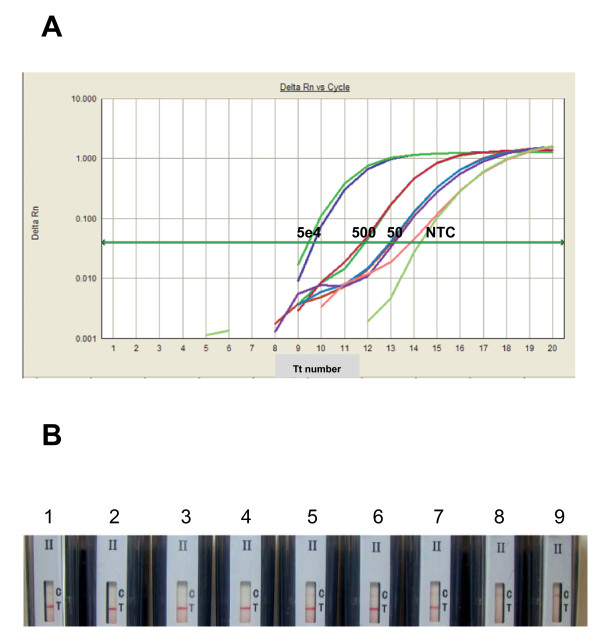
Rapid amplification and detection of Neisseria gonorrhea genomic DNA. Panel A) Fluorescence monitoring in real-time is shown as semi-log plot of fluorescence intensity versus Tt number where each cycle is 1 minute-long. The copy numbers of input template are labeled on the figure. Panel B) Type II BESt™ cassette detection of 5e4 copies/assay (strips 1-2), 500 copies/assay (strips 3-4), 50 copies/assay (strips 5-7), and non template control (NTC) (strips 8-9). The signal from NTC (either in panel A or B) is the amplification signal from the internal control sequence. The IC sequence shares the same primer sequence with the detected target gene of Neisseria gonorrhoeae, just with different internal nucleic acid sequence between the primers. The IC sequence is cloned into a plasmid. When a reaction is set-up, the IC plasmid is premixed with all of the other reaction components (except the target DNA or tested clinical samples) to prepare the master mix of the assay. When there is no target template of Neisseria gonorrhoeae (or negative clinical samples) in the assay, the IC sequence is amplified. Because the different internal sequence between the IC sequence and the target sequence of Neisseria gonorrhoeae, different probes are designed and included in the reaction. This can be differentiated from T line (Test line: for the detection of target DNA amplification products by target probe NGP) and C line (Control line: for the detection of internal control amplification products by IC probe NGICP) in Panel B.